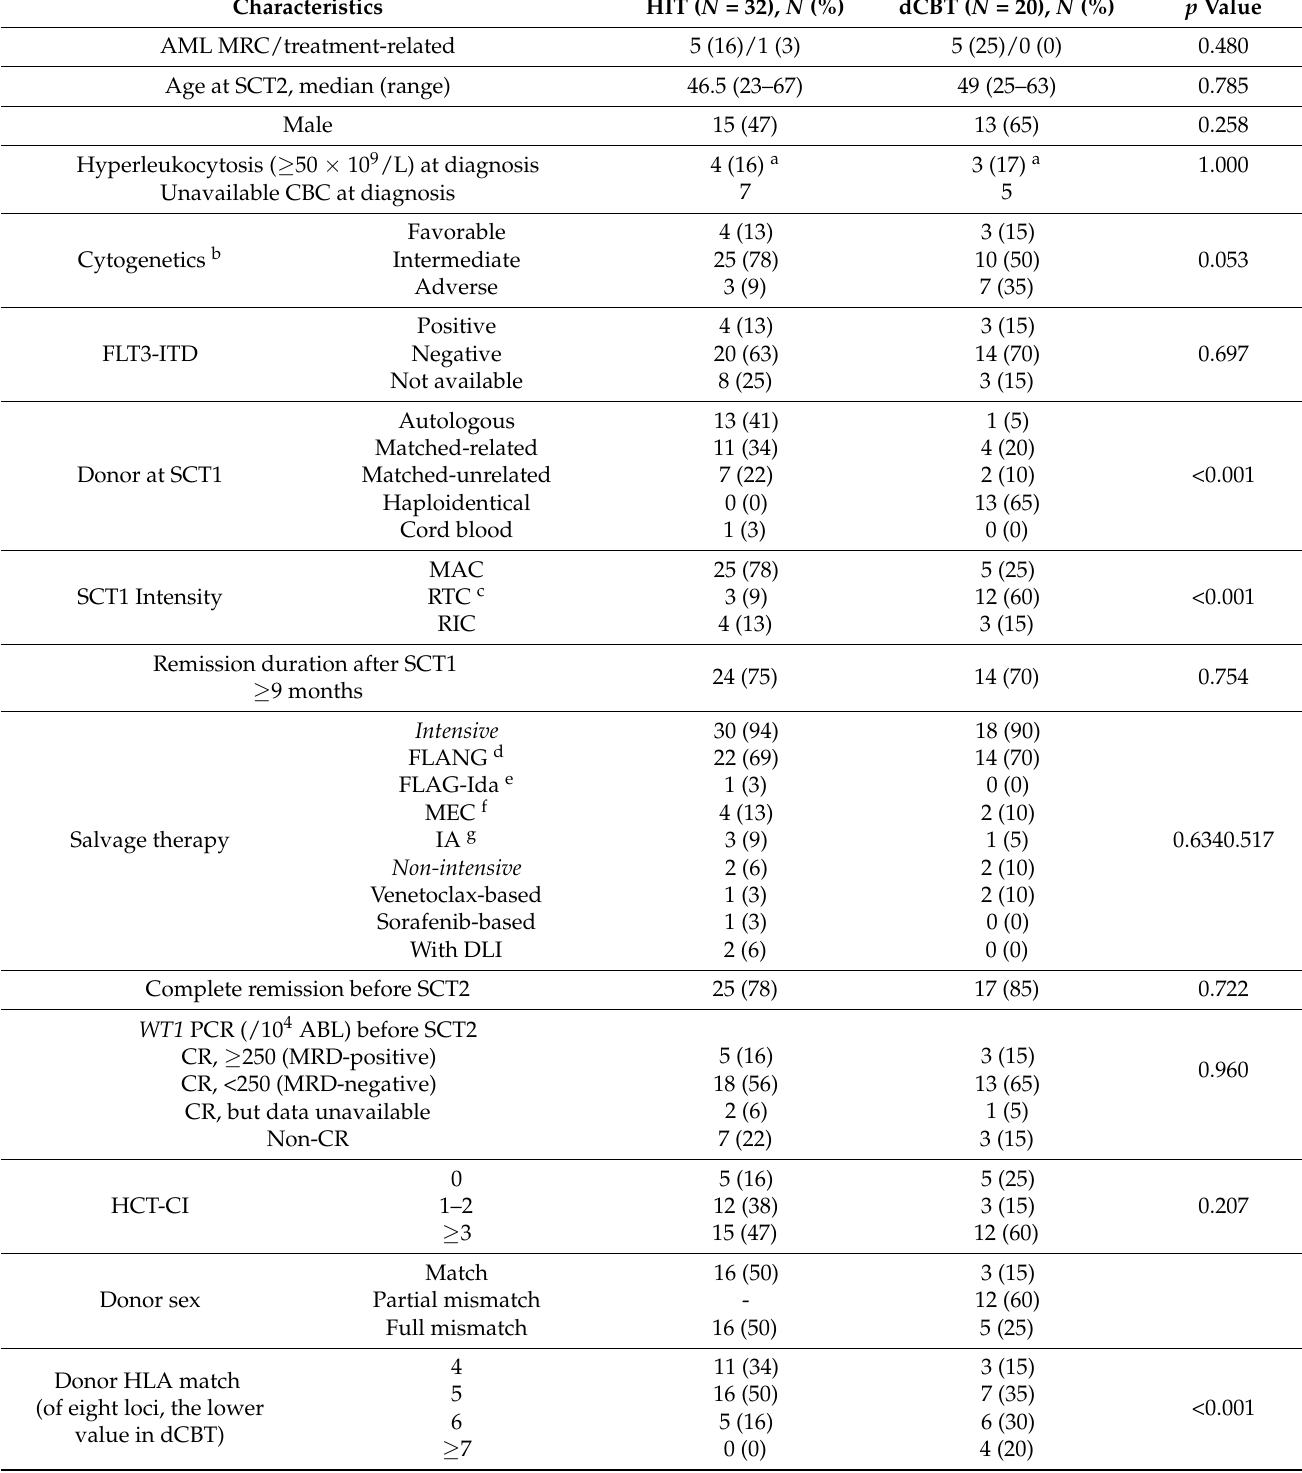
Table 1. Patient